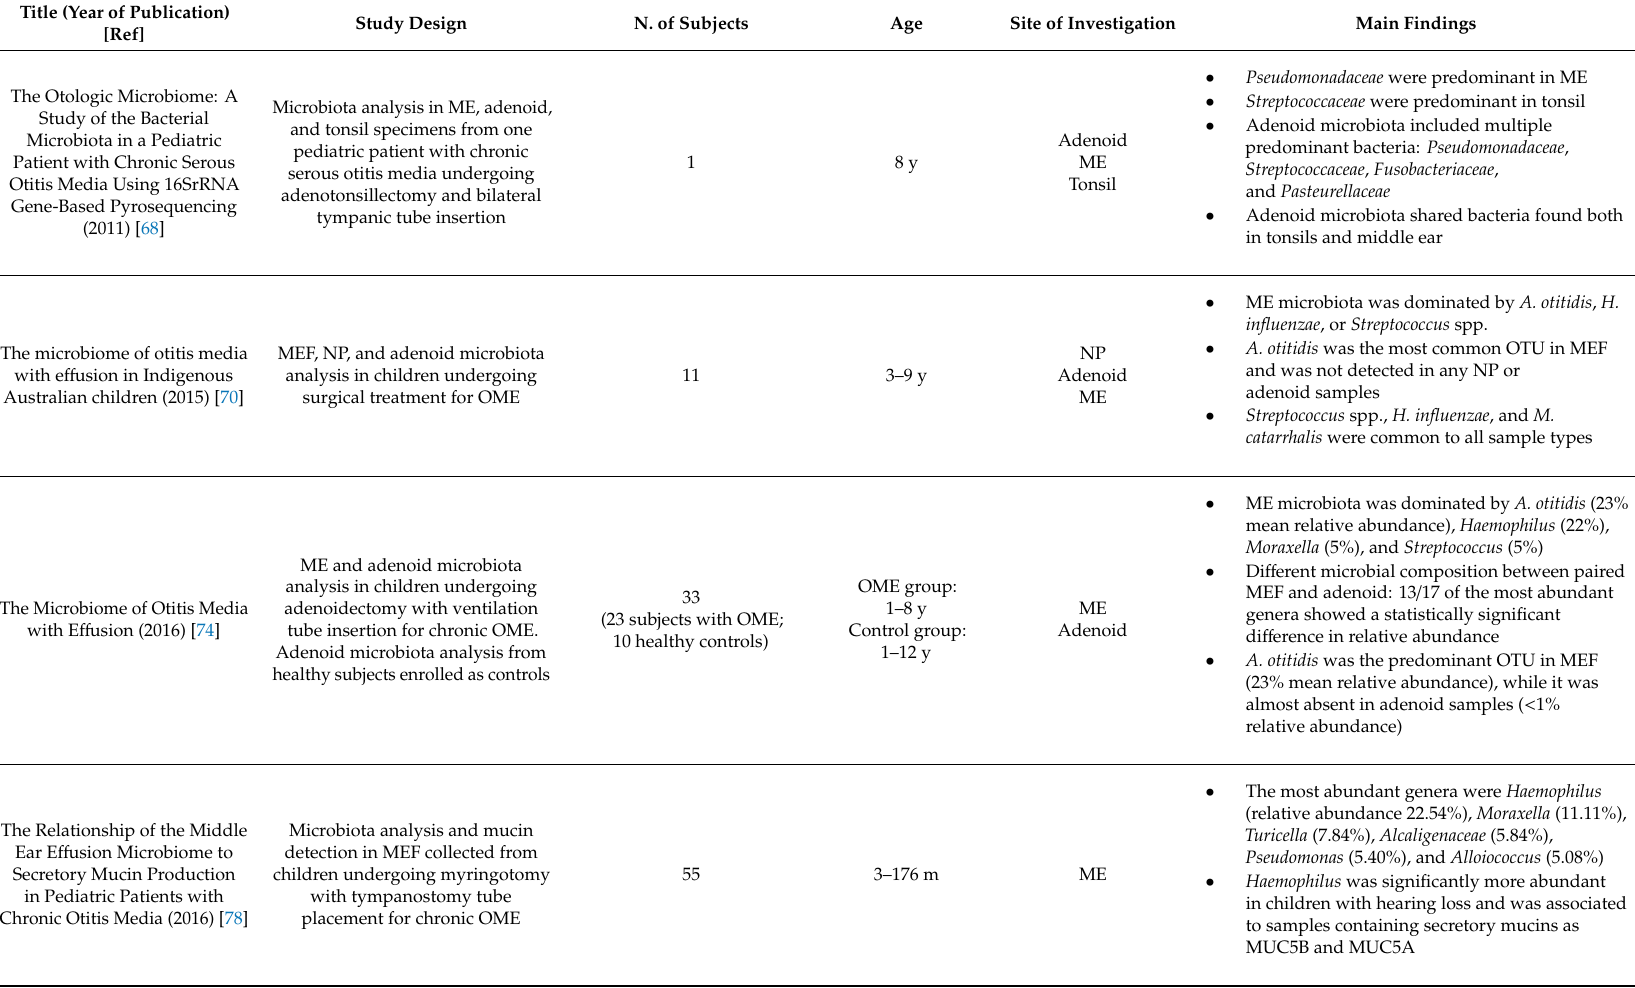
Table 3. Overview of investigations on microbiota and otitis media with e ff usion discussed in this